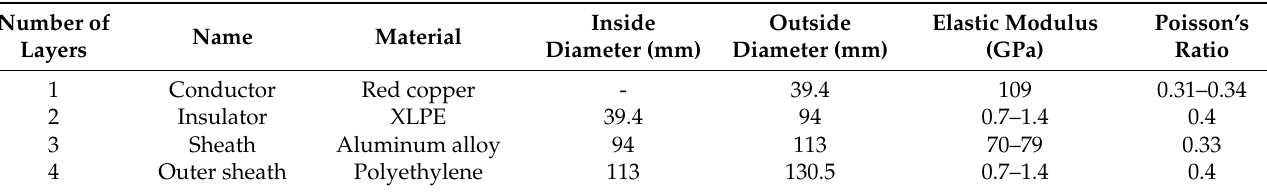
Table 2. Parameters of cable used in experiments.